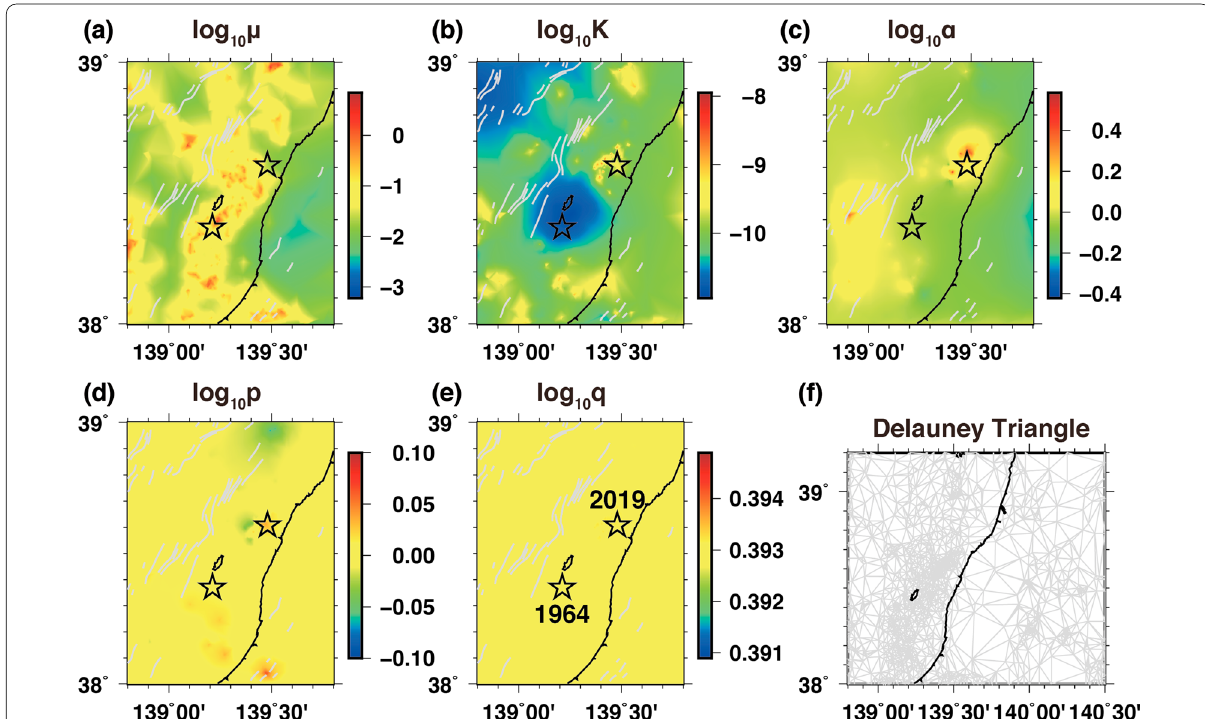
Fig. 2 Spatial distribution of the optimal maximum posterior estimates for the respective parameter functions that were determined via the HIST-ETAS model. a Common logarithm of µ -values. b Common logarithm of K -values. c Common logarithm of α -values. d Common logarithm of p -values. e Common logarithm of q -values. The two black stars denote the epicenters of the 1964 Niigata (lower) and 2019 Yamagata-Oki (upper) earthquakes. Gray lines are the surface traces of active Quaternary faults. f The Delaunay tessellation used for the smoothing penalties via the HIST-ETAS model. The Delaunay tessellation encompassed the entire study region shown in Fig. 1a,